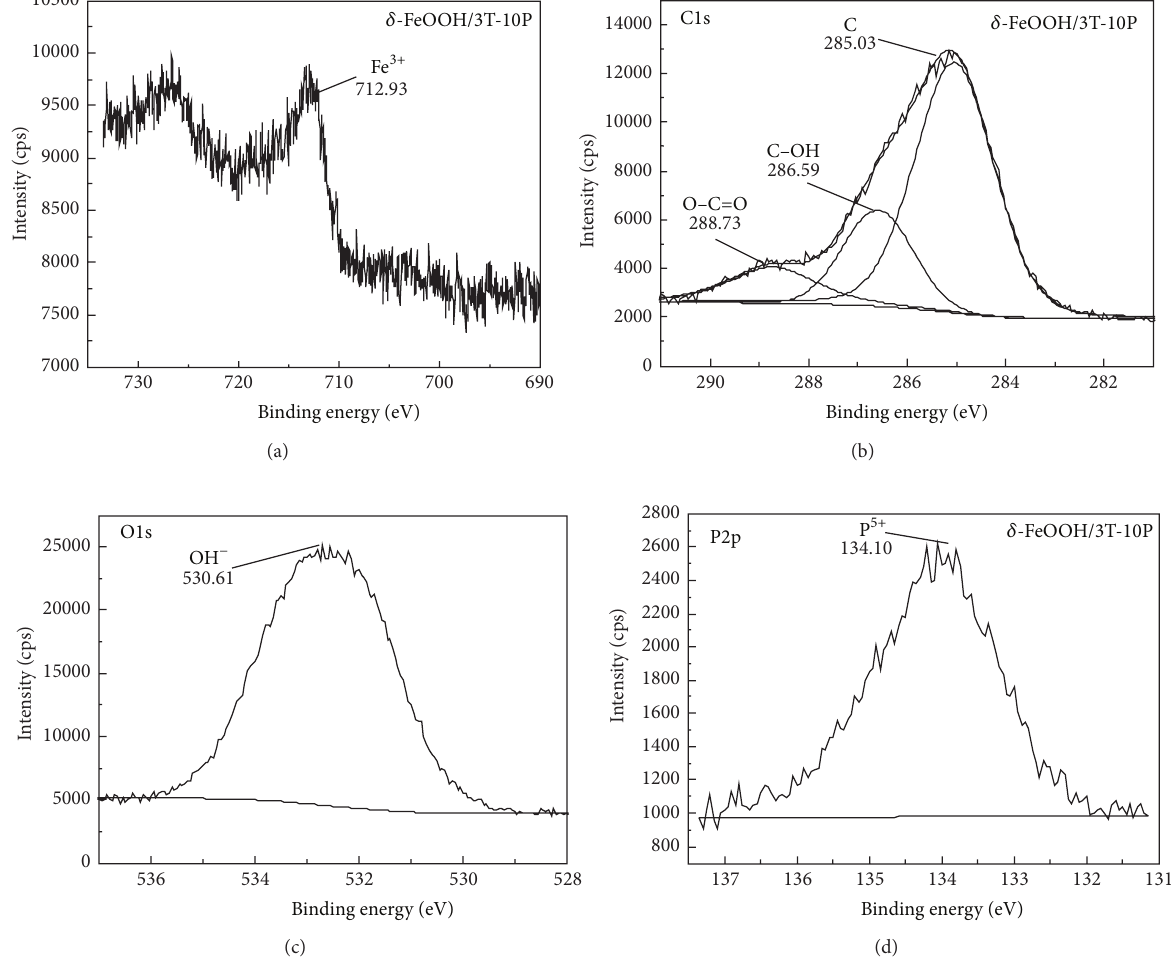
Figure 9: XPS spectra of the products formed from the reaction of 𝛿 -FeOOH and